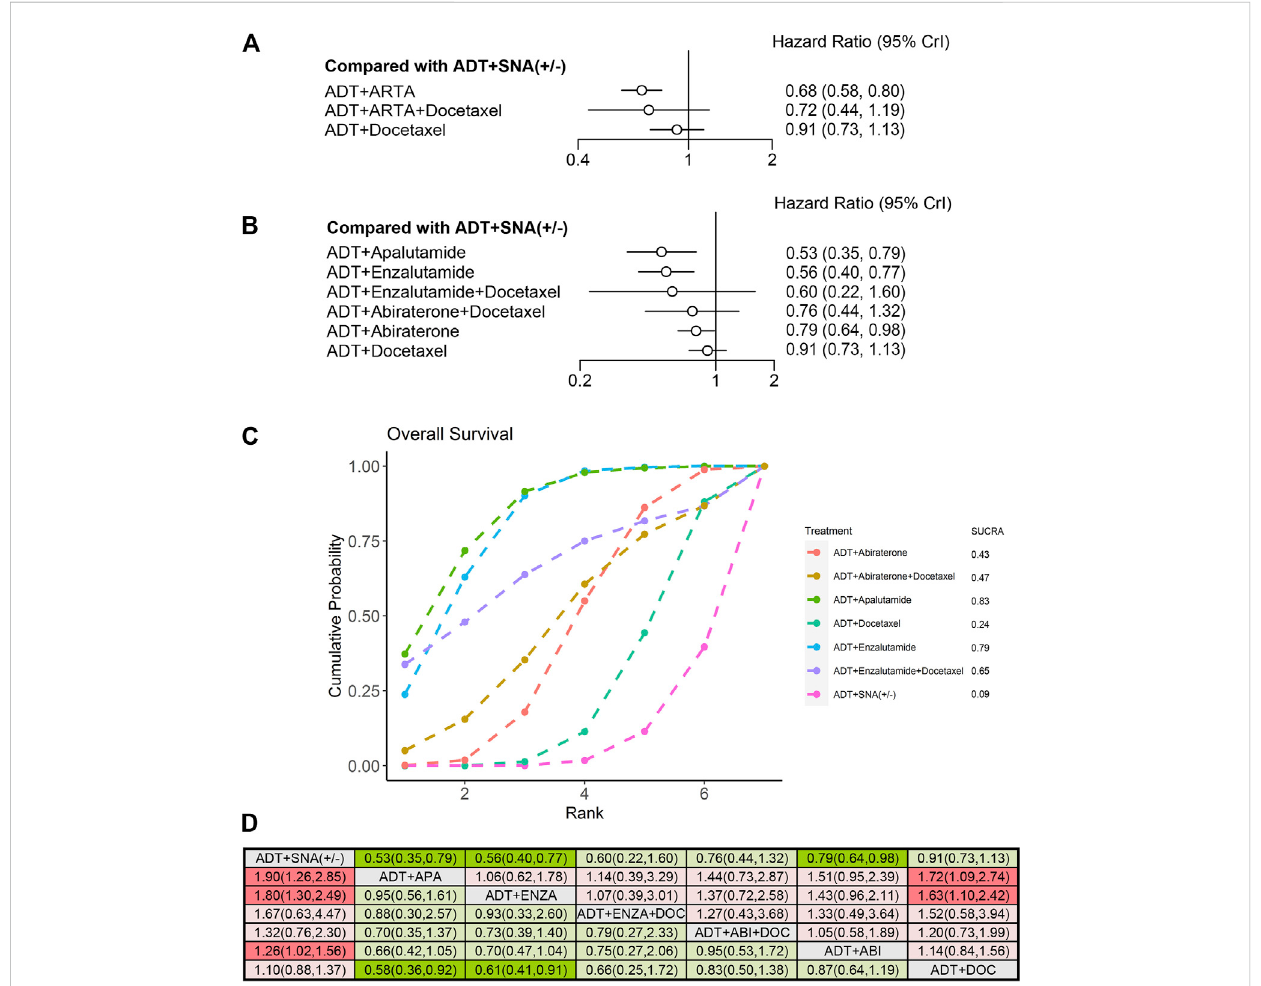
FIGURE 6 Comparison of therapies for improving OS in patients with low-volume disease. (A) Forest plot representing HR for combination therapy compared with ADT with or without SNA. (B) Forest plot representing HR for speci fi c therapy compared with ADT with or without SNA. (C) SUCRA plot showing the treatment ranking of speci fi c therapies. (D) League table of NMA comparing the OS. Comparison is located at the intersection of the column-de fi ning treatment and the row-de fi ning treatment. The results are presented in HR with 95% CrI. HR > 1 (red) favors row-de fi ning treatment, and HR < 1 (green) favors column-de fi ning treatment. The dark red or green represents the results with statistical signi fi cance. DOC, Docetaxel; ABI, Abiraterone, ENZA, Enzalutamide; APA, Apalutamide; OS, overall survival; ADT, androgen deprivation therapy; SNA, standard non-steroidal antiandrogen; HR, hazard ratio; NMA, network meta-analysis; SUCRA, surface under the cumulative ranking